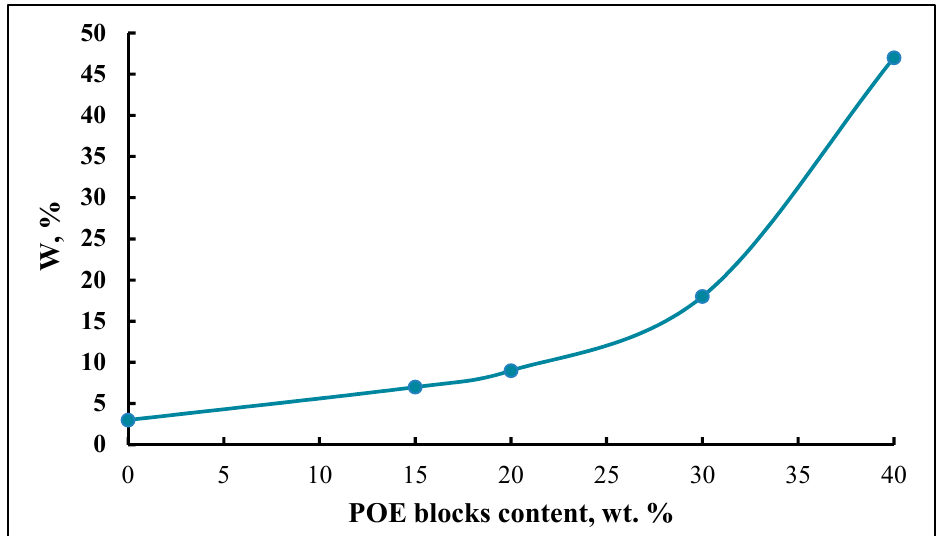
Figure 6. Tensile tests of polymers.